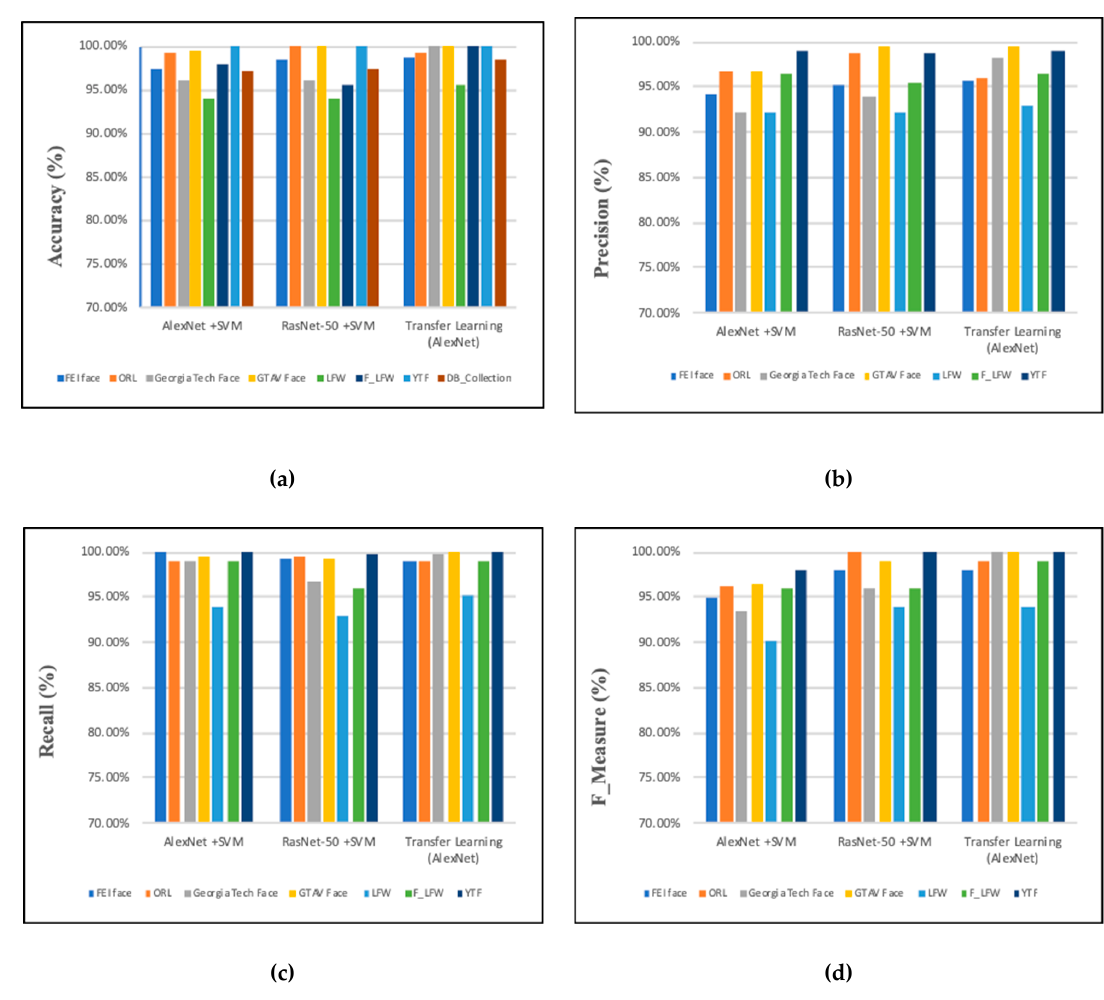
Figure 12 : Performance analysis for approaches with all datasets : ( a ) Accuracy, ( b ) Precision, ( c ) Recall, ( d ) F_Measure Figure 12. Performance analysis for approaches with all datasets: ( a ) Accuracy, ( b ) Precision, ( c ) Recall, ( d ) F_Measure. Appl. Sci. 2019 , 9 , x FOR PEER REVIEW